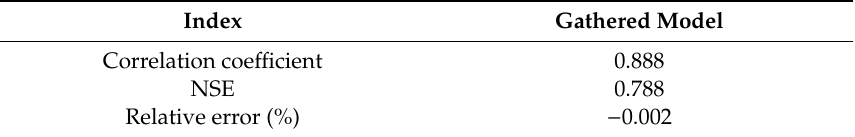
Table 5. Index comparison between measured value and gathered model correction (monthly precipitation from 1961 to